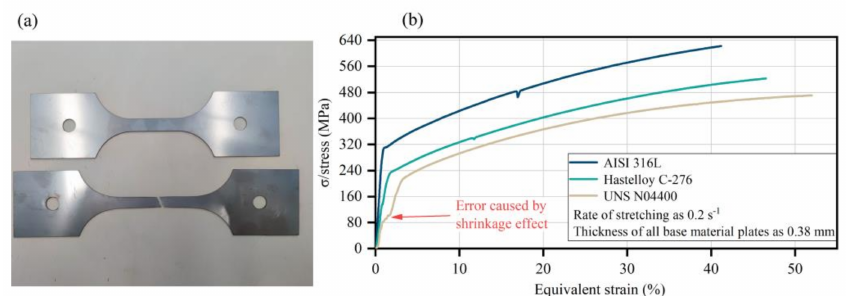
Figure 3. ( a ) Tensile test specimens; ( b ) Stress–strain curves for different substrates of rupture